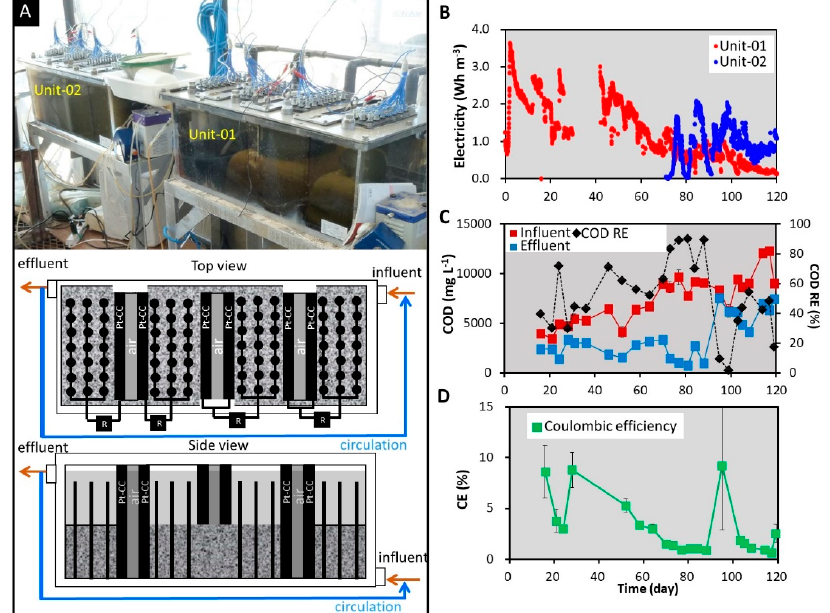
Figure 3. The configuration and photo of ( A ) the 100 L-microbial fuel cell (MFC), and changes in ( B ) electricity production, ( C )COR RE, and ( D ) Coulombic efficiency during swine wastewater treatment. The data recorded by the data logger for (B) during days 30–41 could not be retrieved.